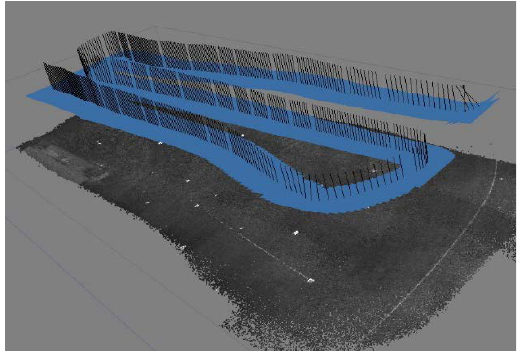
Figure 5 – Screenshot for Photoscan showing the alignment of 3 passes of image data and the sparse pointcloud that was created.